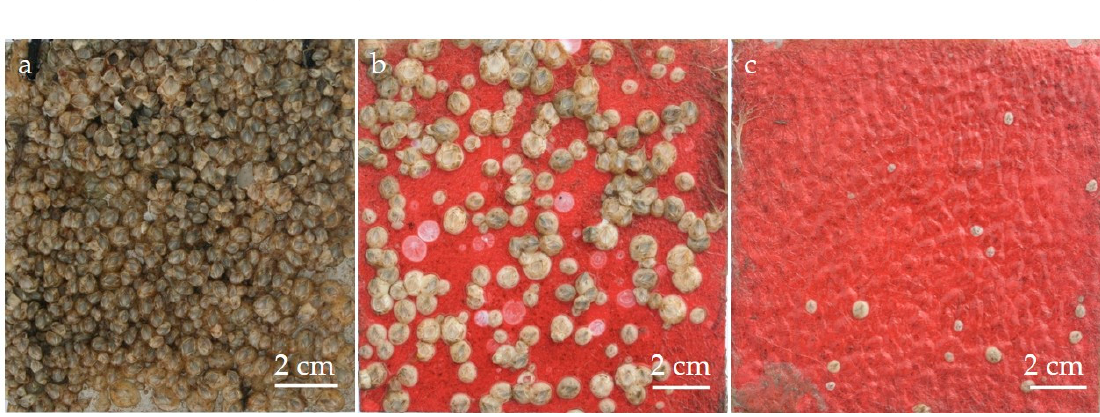
Figure 4. Adhesion of barnacles to surfaces after 12 weeks of exposure to the North Sea (after cleaning). ( a ) V2A-steel reference, ( b ) silicone mixture with Poraver particles and ( c ) silicone mixture with Q-Cel.